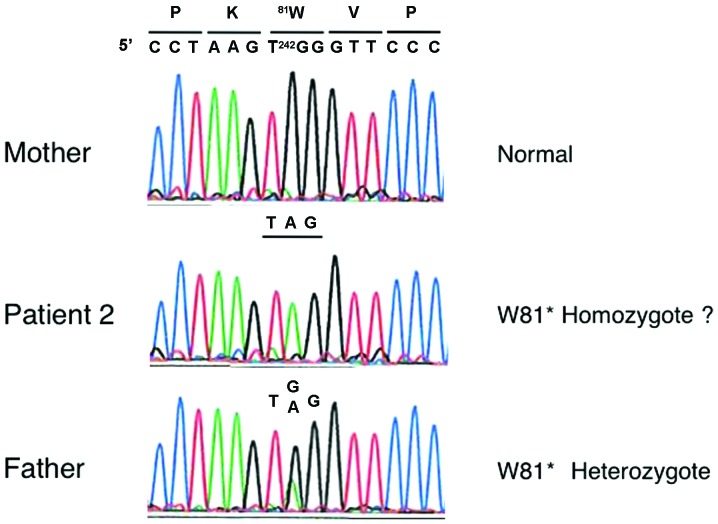
Sequence analysis of patient 2 and his parents. The c.242G>A (p.W81*) mutation site is shown.